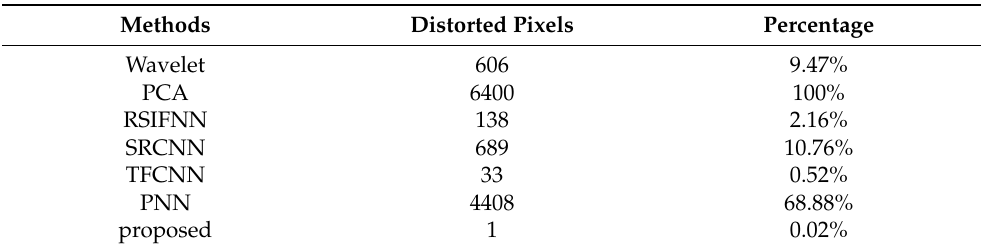
Table 5. The quantitative statistics of distorted pixels of DL-based pansharpening methods (down- sampled GF-1